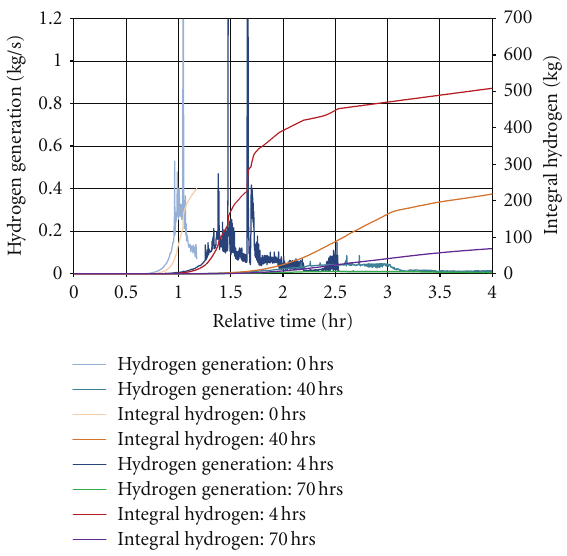
Figure 27: Hydrogen generation rate and integral hydrogen for high-pressure scenarios for scenarios where all of the emergency water injection was terminated at a time varying from 0 hours to 70 hours after